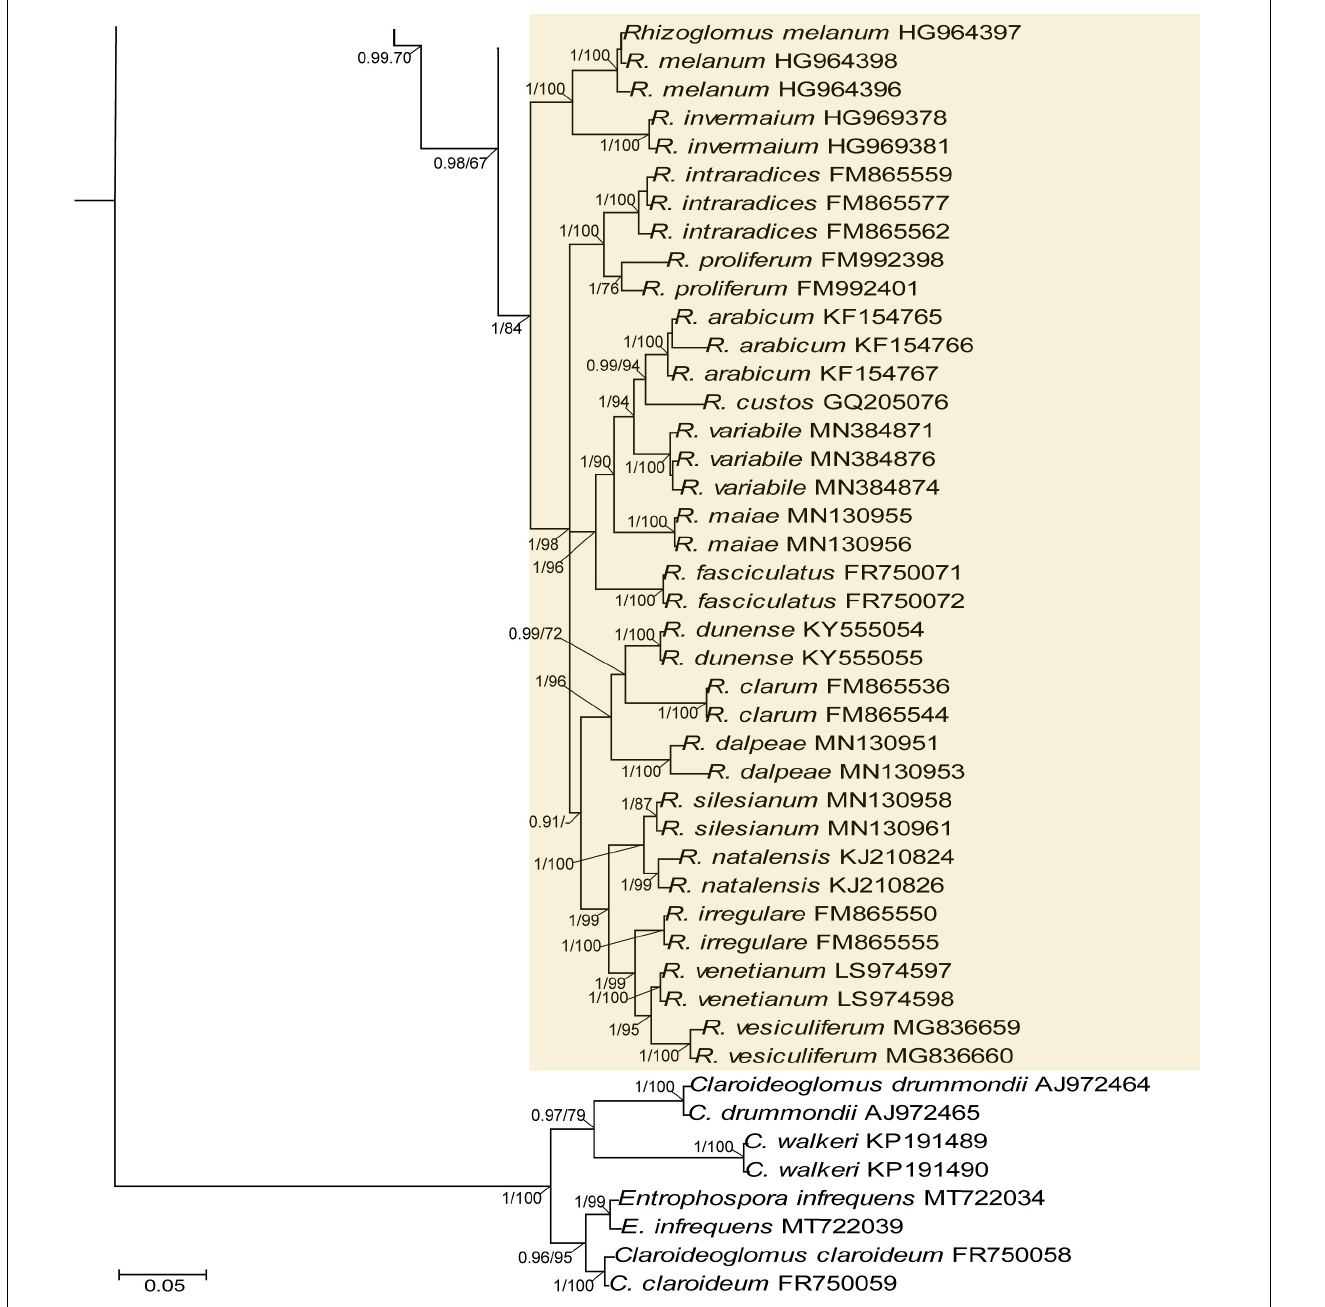
FIGURE 1 | A 50% majority rule consensus phylogram inferred from a Bayesian inference analysis of 18S-ITS-28S nuc rDNA sequences of Dominikia glomerocarpica and Epigeocarpum crypticum , as well as 50 other species of AMF, including Claroideoglomus claroideum , Claroideoglomus drummondii , Claroideoglomus walkerii , and Entrophospora infrequens as outgroup. The Bayesian posterior probabilities ≥ 0.90 and ML bootstrap values ≥ 50% are shown near the branches, respectively. Bar indicates 0.05 expected change per site per branch.